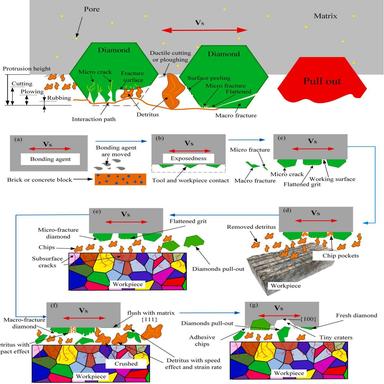
Schematic of wear evolution mechanism of DSs topography.